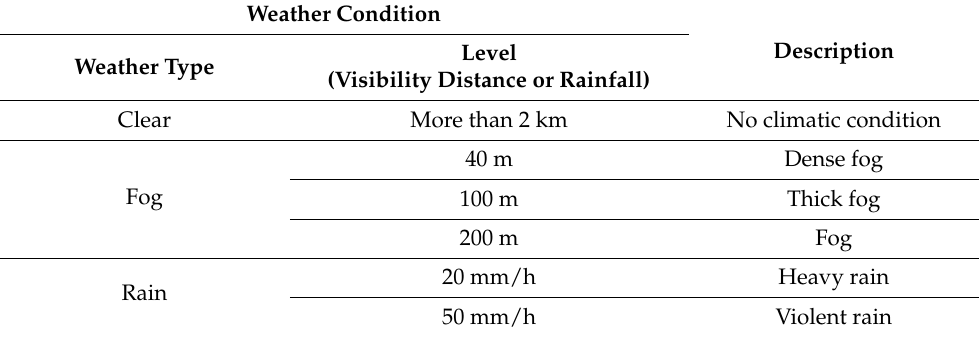
Table 1. Weather conditions for the test. Weather